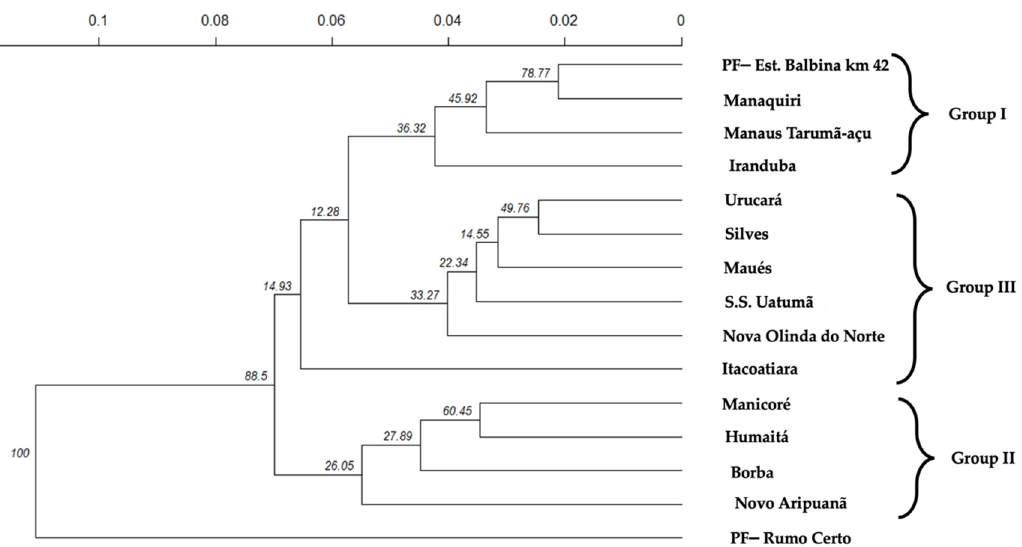
Figure 2. Dendrogram obtained by the “UPGMA” method through Nei’s genetic distances [20] for the 15 populations of A. aculeatum . Numbers above the branches of the dendrogram mean the values in clusters are the highest bootstrap results (resampling 10.000).